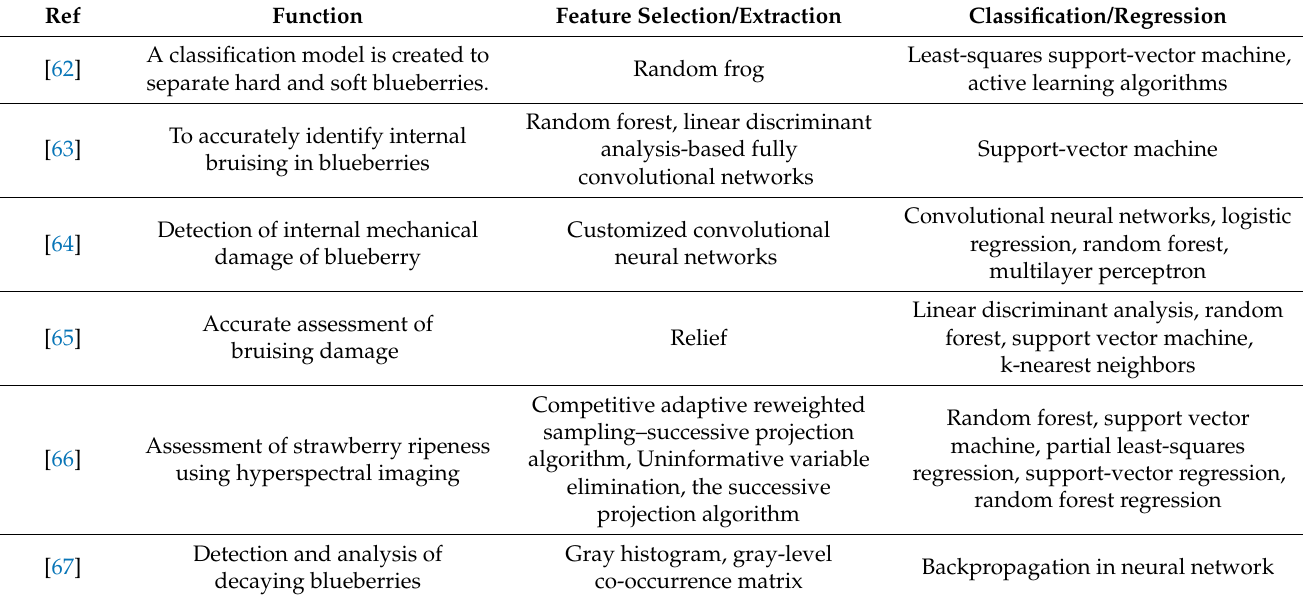
Table 2. AI for horticulture crops.